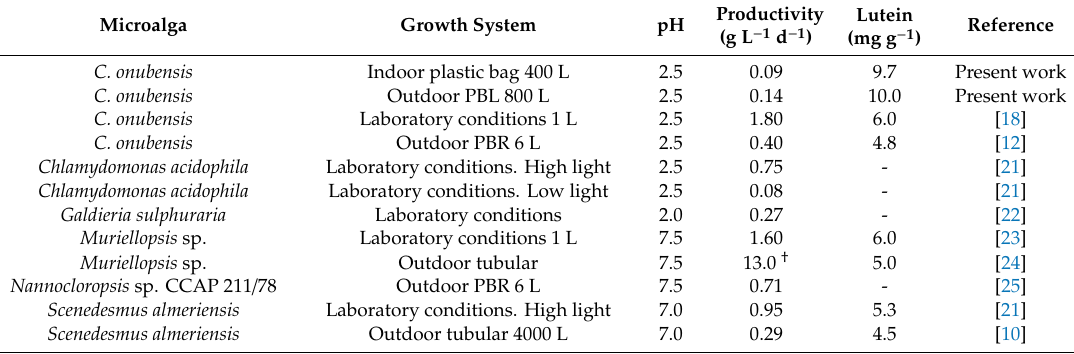
Table 1. Comparative productivity and lutein content of biomass in di ff erent acidophile and non-acidophile microalgae. “PBR” means